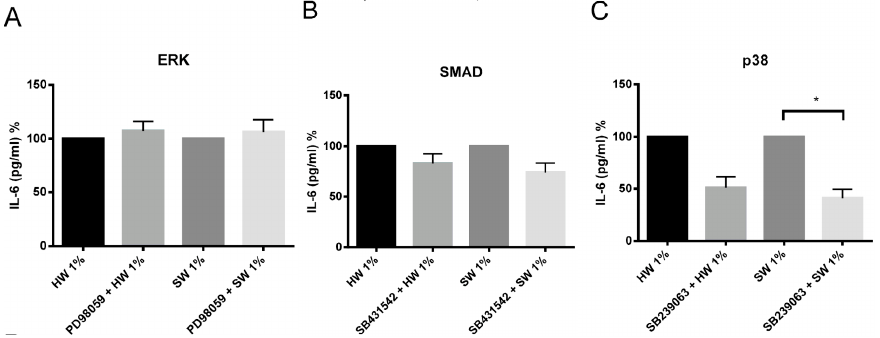
Figure 6. The effects of ERK ( A ), SMAD ( B ), and p38 MAP kinase ( C ) inhibitors on IL-6 production by hardwood and softwood smoke extract. Primary human lung fibroblasts ( n = 4) were pretreated for an hour with signaling inhibitors, PD98059 (10 µM), SB431542 (10 µM), and SB239063 (3 µM) in DMSO (vehicle control) for ERK, SMAD, and p38 MAP kinase pathway, respectively, then stimulated with 1% hardwood and softwood smoke extract for 24 h. Supernatant was collected and IL-6 concentration analysis was executed via ELISA. Data are expressed as the percent of inhibition from control and bars represent mean ± SEM. Statistical analysis was executed by using repeated measures, one-way ANOVA with Tukey’s post-test. Significance is represented as * p < 0.05.